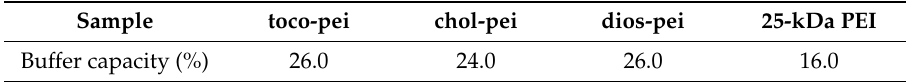
Table 2. Buffering capacity.